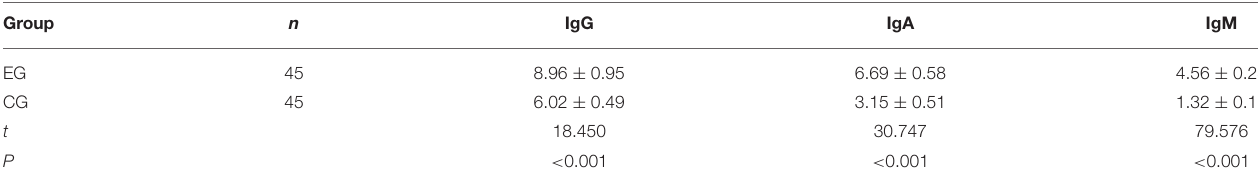
TABLE 2 | Comparison of immune function indexes [Mean ±